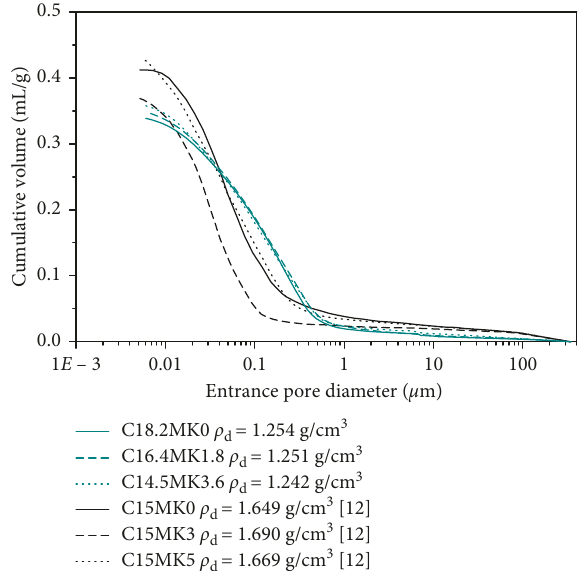
Figure 5: Cumulative volume of the samples treated by MK-blended cement.